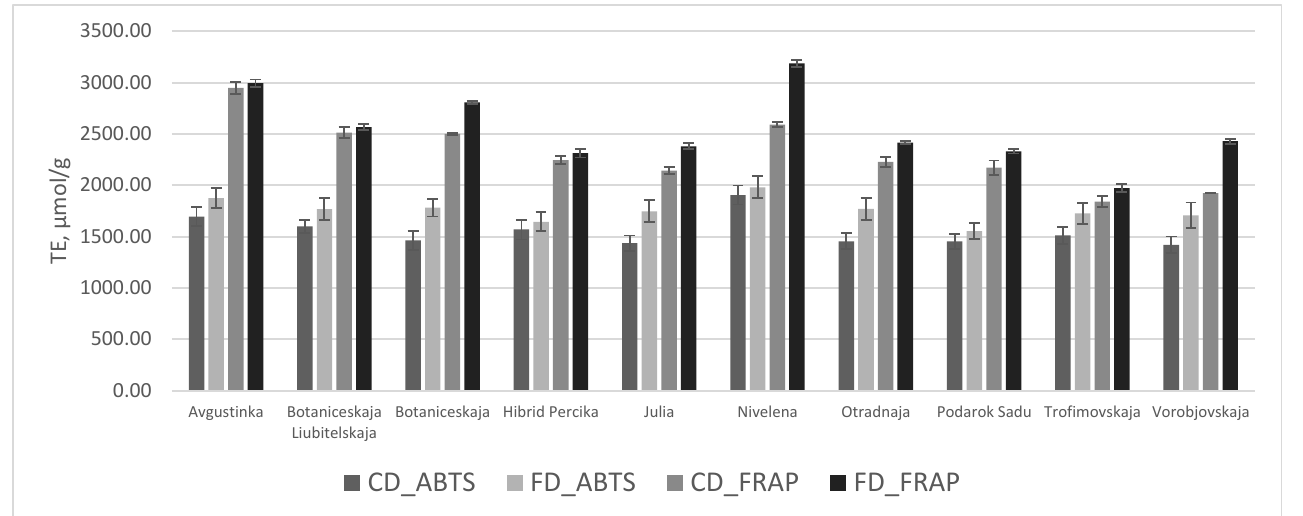
Figure 2. Trolox equivalent antioxidant activity values (TE, µmol/g) of convection-dried (CD) and freeze-dried (FD) HR cultivars’ leaf powders.